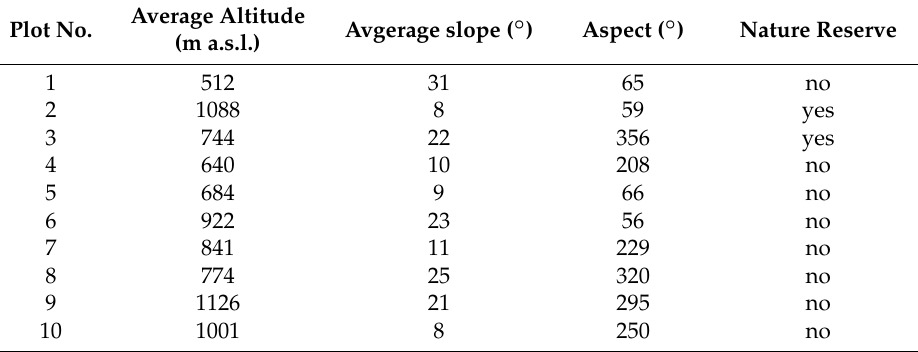
Table 1. Information overview for experimental dataset research plots.